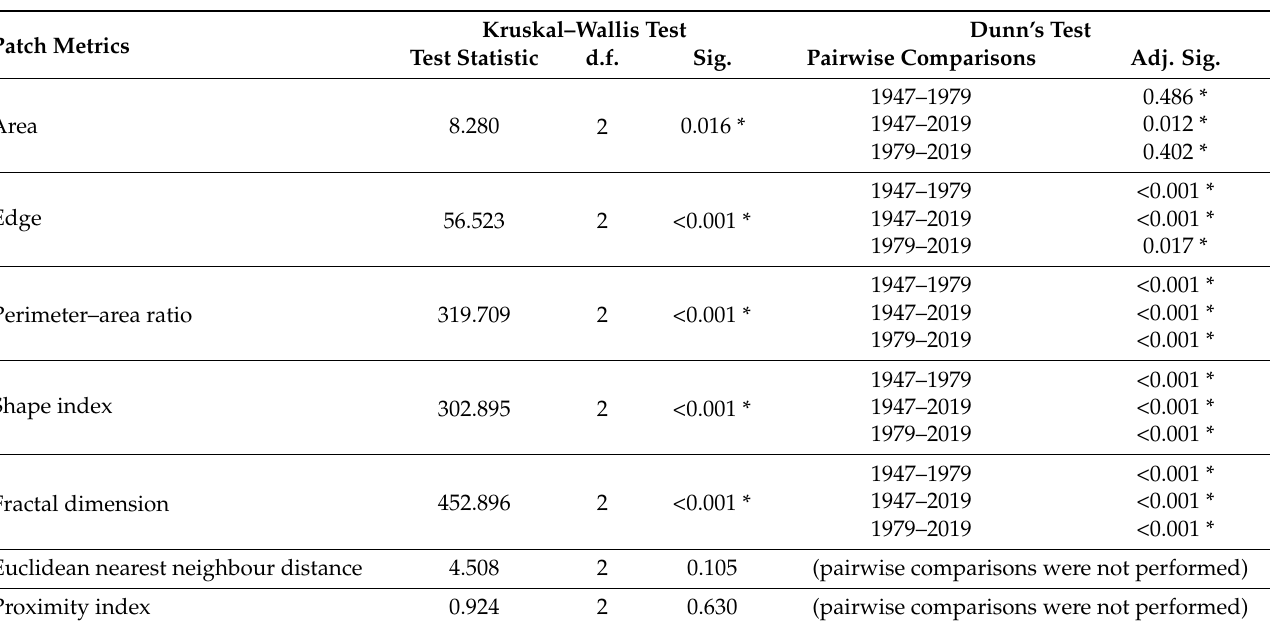
Table 6. Outputs of the Kruskal–Wallis test (and post hoc pairwise comparisons) on patch metrics, considering the analysis for the TRS class (N = 2321; significance values for Dunn’s test were adjusted by the Bonferroni correction for multiple